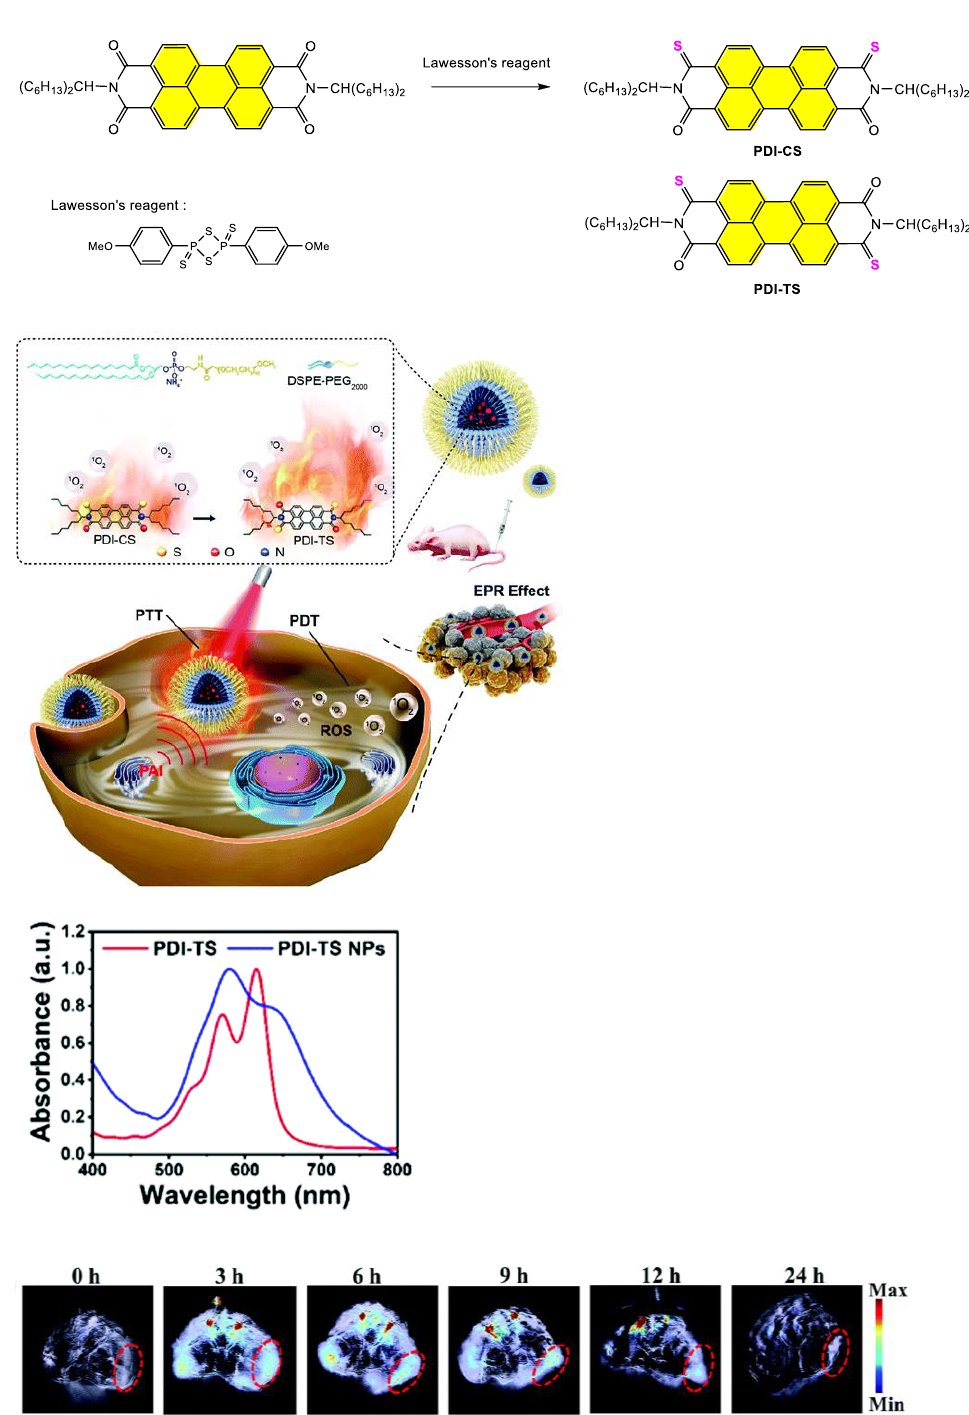
Figure 4. Synthesis of bis-thiono-PDIs, PDI-CS and PDI-TS; illustration of PTT and PDT in vivo using PDI-CS- and PDI-TS-based NPs; UV-Visible absorption spectra of PDI-TS in THF and NPs in deionized water; in vivo photoacoustic images in tumour-site post-injection of PDI-TS NPs. Reprinted with permission from reference [101]. Copyright 2020 Royal Society of Chemistry.